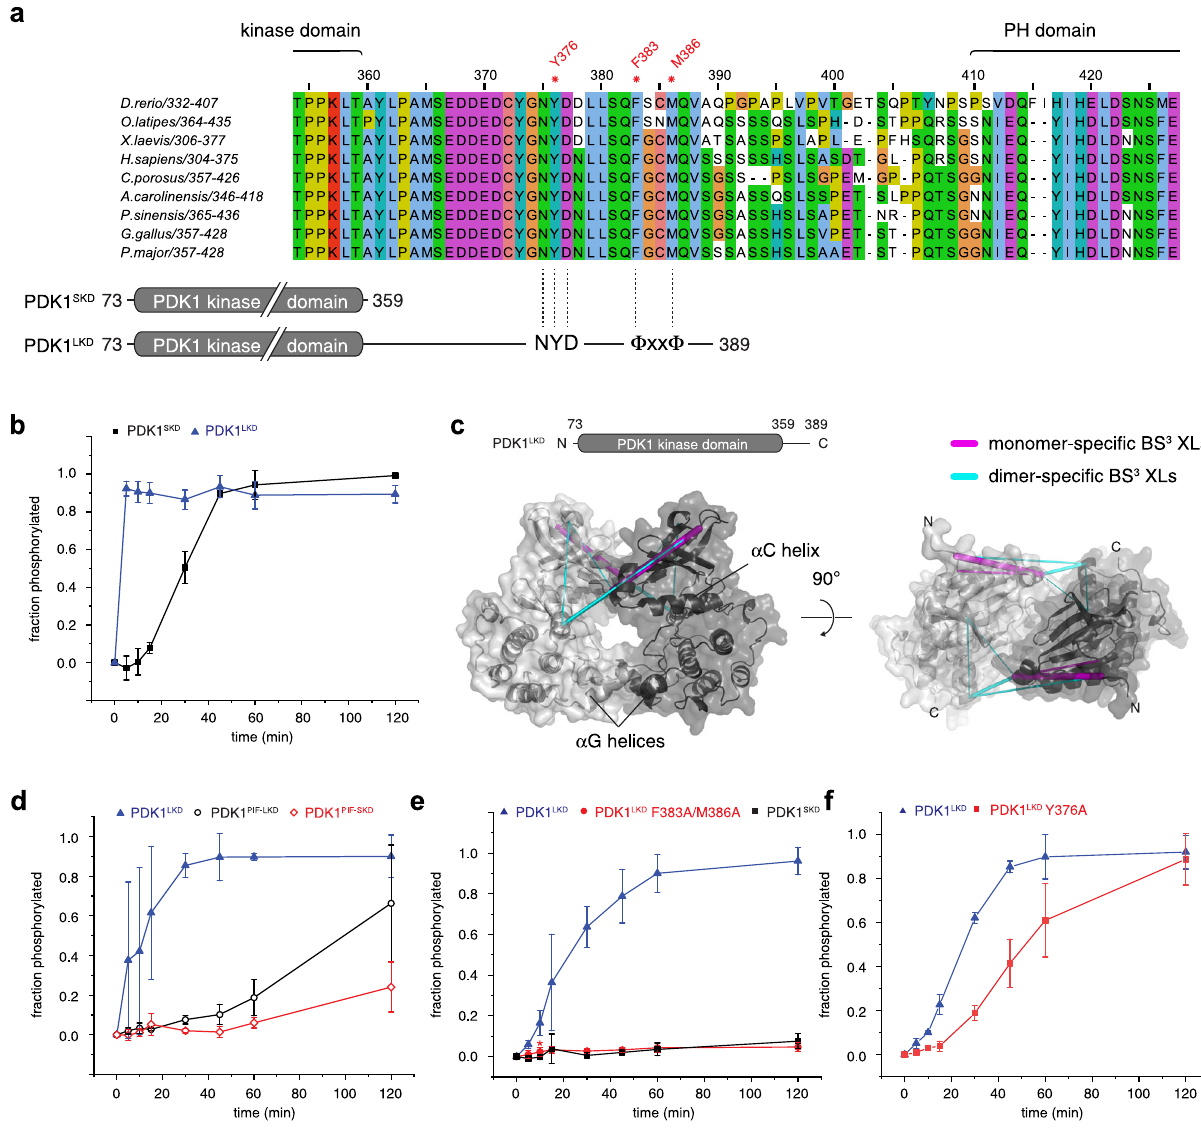
Fig. 3 A hydrophobic motif in PDK1 drives trans -autophosphorylation. a Alignment of the kinase-PH interdomain linker of chordate PDK1 orthologs. Below: schematic of the PDK1 SKD and PDK1 LKD constructs with relative positions of the ‘ NYD ’ and hydrophobic ( Φ xx Φ ) motifs. b Radiometric autophosphorylation assay. PDK1 SKD (closed black squares) and PDK1 LKD (closed blue triangles). n = 3 biologically independent experiments. Data are presented as mean values ± S.D. c Crosslinking mass spectrometry analysis of PDK1 LKD S241A in the presence of 1 mM ATP. BS3-crosslinked peptides are mapped on the model of the kinase domain dimer. Monomer-speci fi c crosslinks are shown in purple, dimer-speci fi c crosslinks are shown in cyan. d Radiometric autophosphorylation assay. PDK1 LKD (closed blue triangles), PDK1 PIF-LKD (open black circles), and PDK1 PIF-SKD (open red diamonds). n = 3 biologically independent experiments. Data are presented as mean values± S.D. e Radiometric autophosphorylation assay. PDK1 LKD (closed blue triangles), PDK1 LKD F383A/M386A (closed red circles), and PDK1 SKD (closed black squares). n = 3 biologically independent experiments. Data are presented as mean values ± S.D. (red asterisk indicates removal of one outlier). f Radiometric autophosphorylation assay. PDK1 LKD (closed blue triangles) and PDK1 LKD Y376A (closed red squares). n = 3 biologically independent experiments. Data are presented as mean values ±